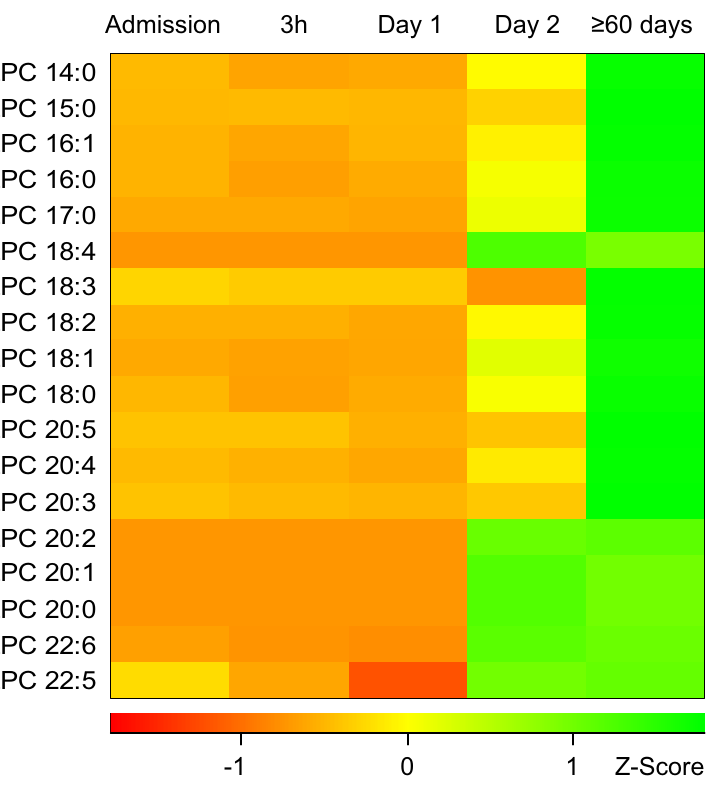
Fig 3. Heat-map illustrating the change of concentrations of 18 LPC species during CAP. Red indicates low concentrations and green high concentrations. The concentration values have been transformed into a Z-Score, which indicates how many standard deviations a concentration is from the mean of all values in each row. A small uniform value of 0.167 μ M was used in instances of less than three samples having concentrations above the lowest level